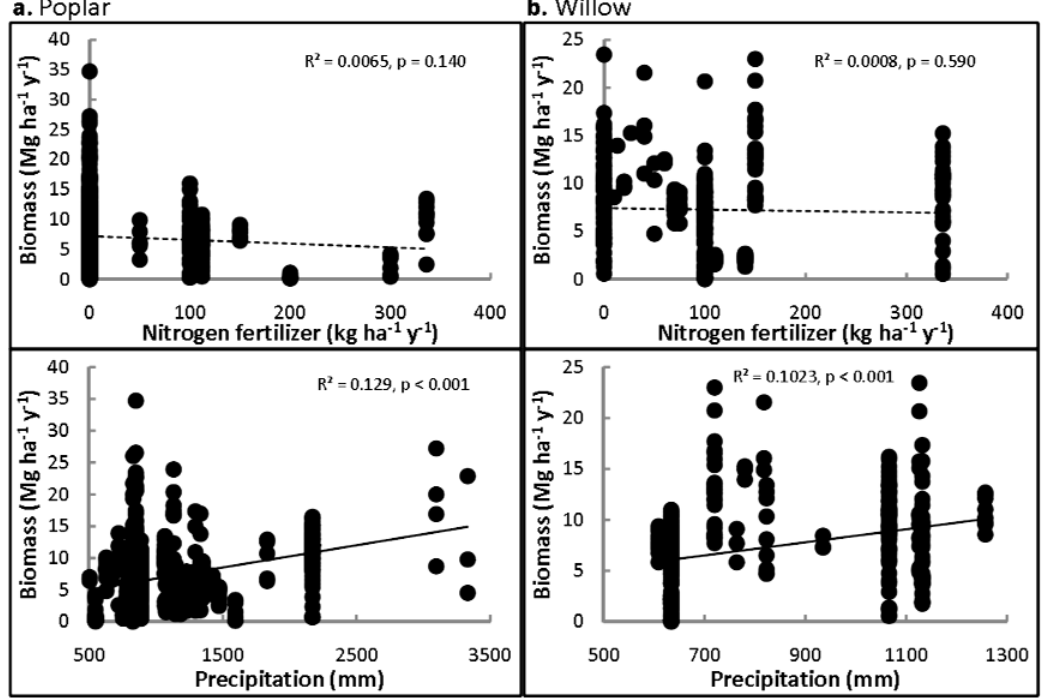
Figure 4. Yield responses of short-rotation poplar ( a ) and willow ( b ) to fertilization (upper) and precipitation